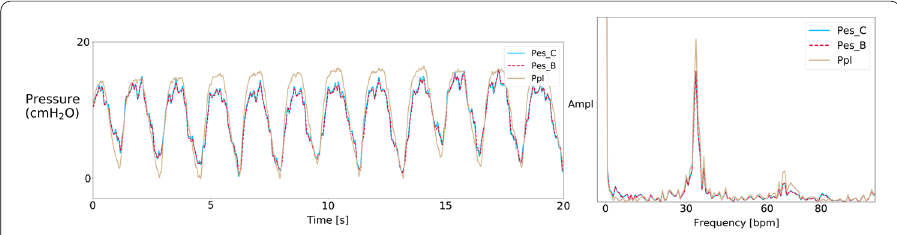
Fig. 5 Power spectral analysis of esophageal and pleural pressure signals. The frequency spectra (right) and esophageal pressure signals (left) of both air-filled catheter and balloon catheter revealed concordant predominant respiratory component (large peak at 33 bpm) but also cardiogenic noise from heart rate component (second peak at 80 bpm). Pleural pressure curve and superposition of the three curves with their spectra are